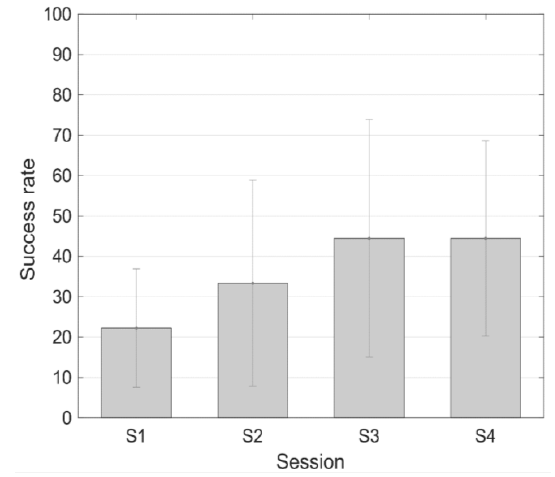
Figure 7. Success rate (mean ± standard error of the mean) during the different sessions of the protocol with longer training periods.